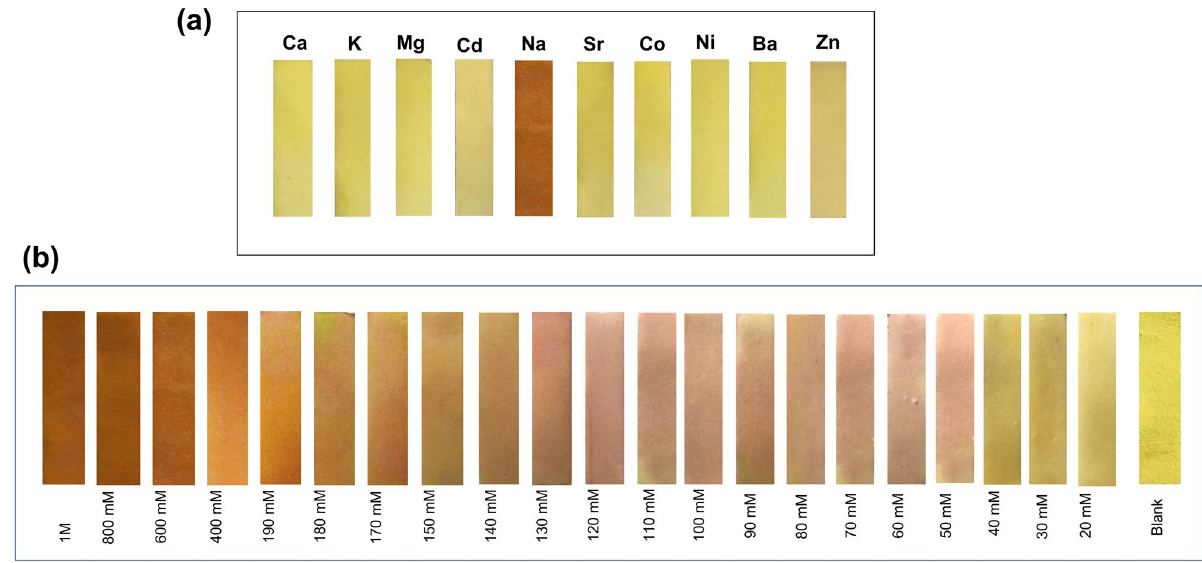
Figure 7. ( a ) Selective visual colorimetric response of Na + . Photograph of CuC paper test strips exposed to different metal ions. ( b ) Photographs of CuC based test strip with increasing concentration of Na + from 20 mM to 1 M exhibiting color